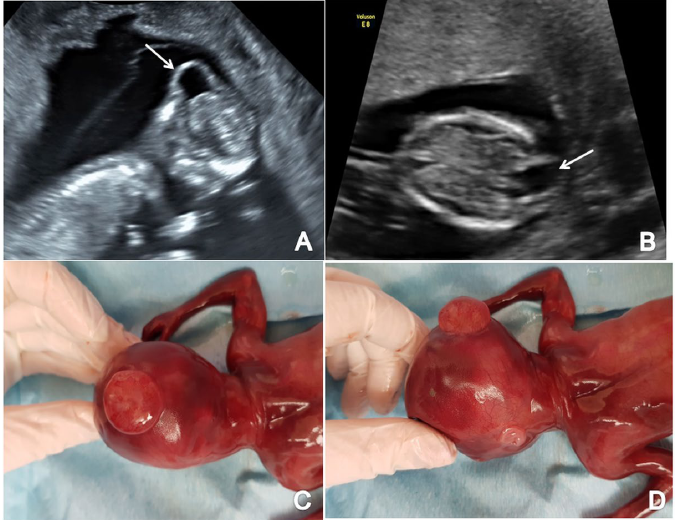
Figure 5. Ultrasound image of occipital cephalocele (the arrow marks the bony defect), diagnosed at 13 weeks + 6 days (Case 13): ( A ) sagittal view by transvaginal approach; ( B ) axial view by transabdominal approach; ( C , D ) specimen presentation after medical TOP.